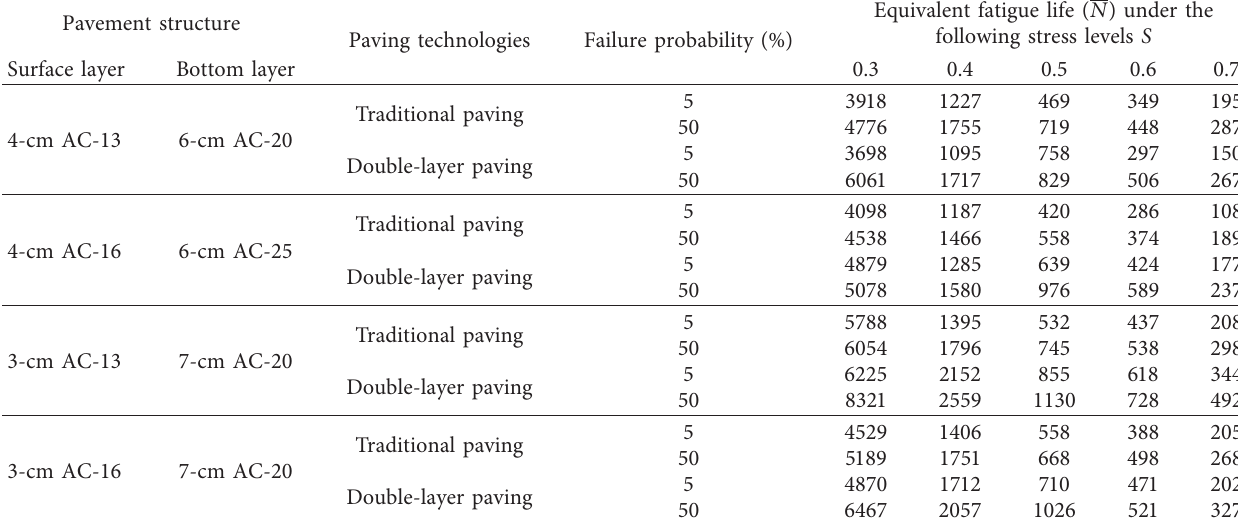
Table 7: Equivalent fatigue lives of specimens under different failure